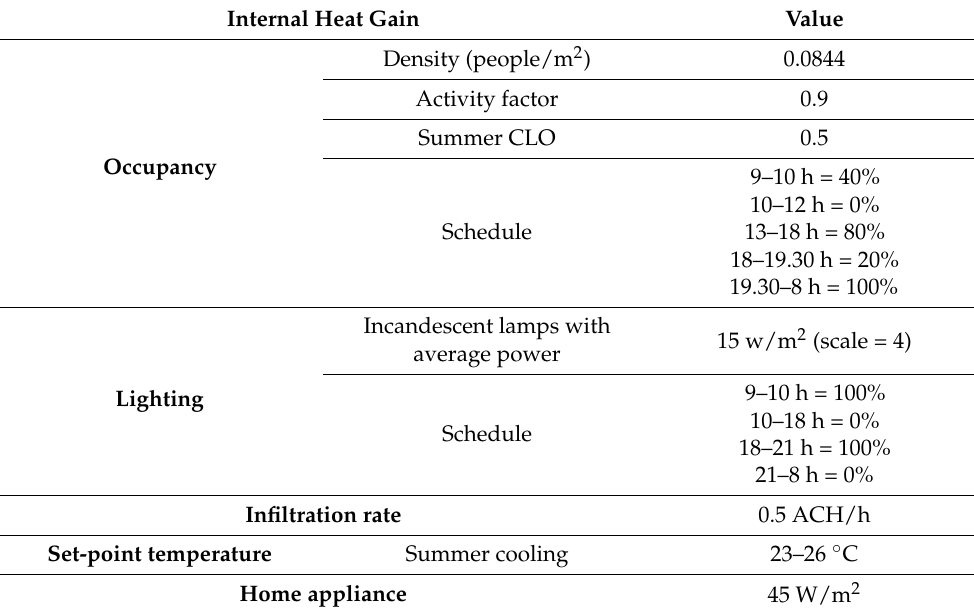
Table 3. Internal heat gain for building